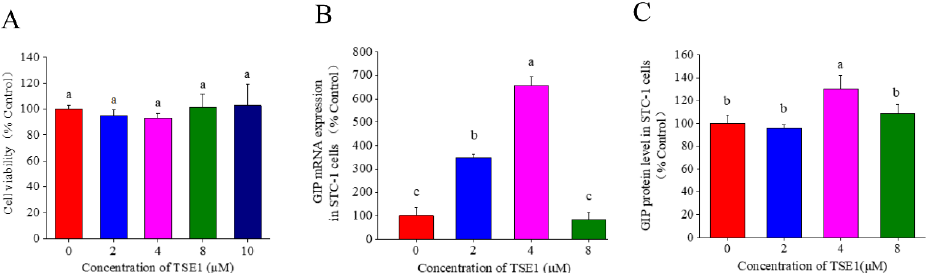
Figure 2. Effect of TSE1 on the GIP expression in STC-1 cells at 24 h. ( A ) Cell viability after 24 h treatment of TSE1 determined by MTT assay. ( B ) The mRNA expression of GIP determined by RT-PCR. ( C ) The protein level of GIP in the cell culture media determined by ELISA. Different letters indicate significant difference among groups ( p < 0.05).